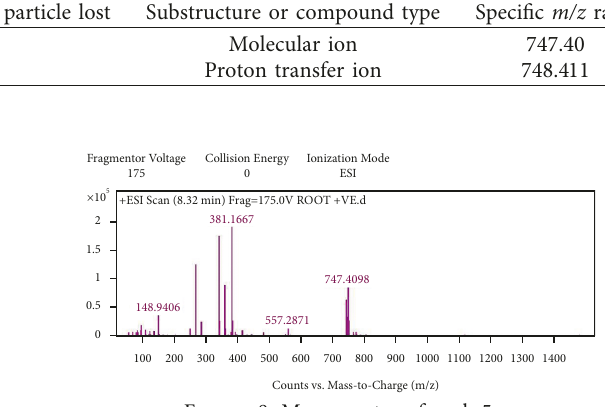
Figure 8: Mass spectra of peak